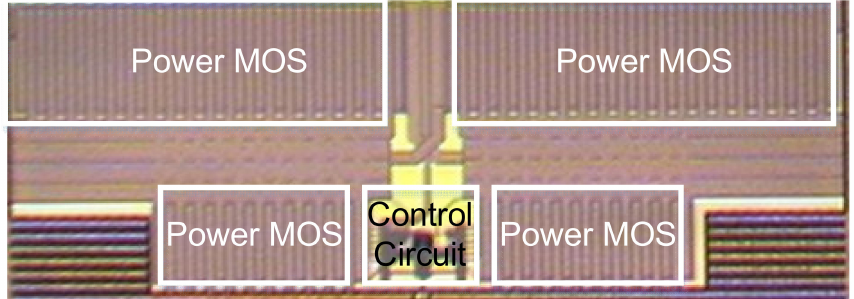
Figure 11. Microphotograph of the proposed circuit.